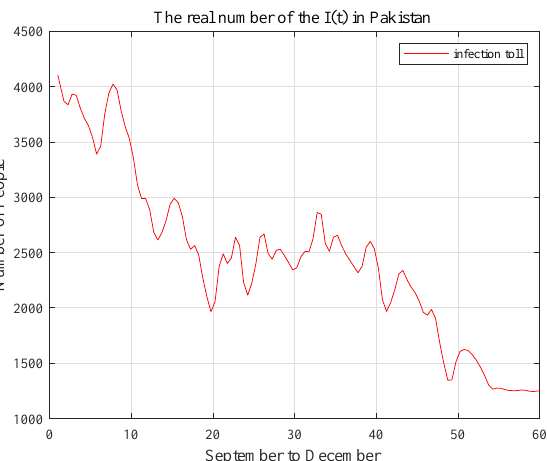
Figure 3. The number of the daily statistics of quarantined people in Pakistan from September to December 2021.